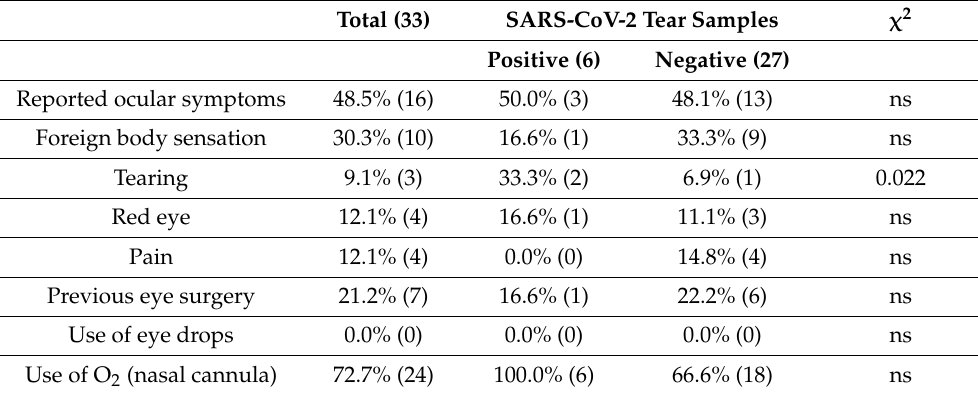
Table 2. Ocular symptoms were reported on high